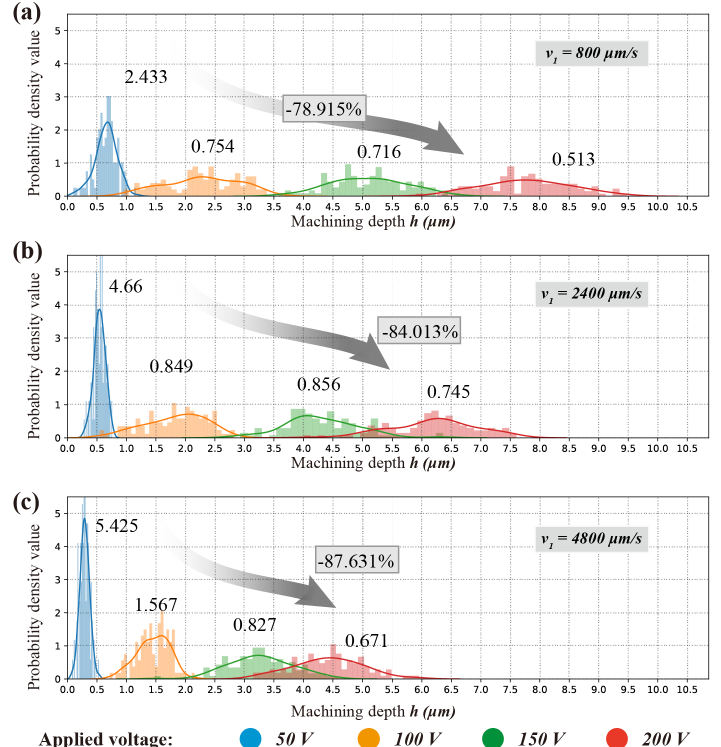
Figure 11. Probability density value of machining depth h with different nozzle speed: ( a ) v 1 = 800 µ m/s; ( b ) v 2 = 2400 µ m/s; ( c ) v 3 = 4800 µ